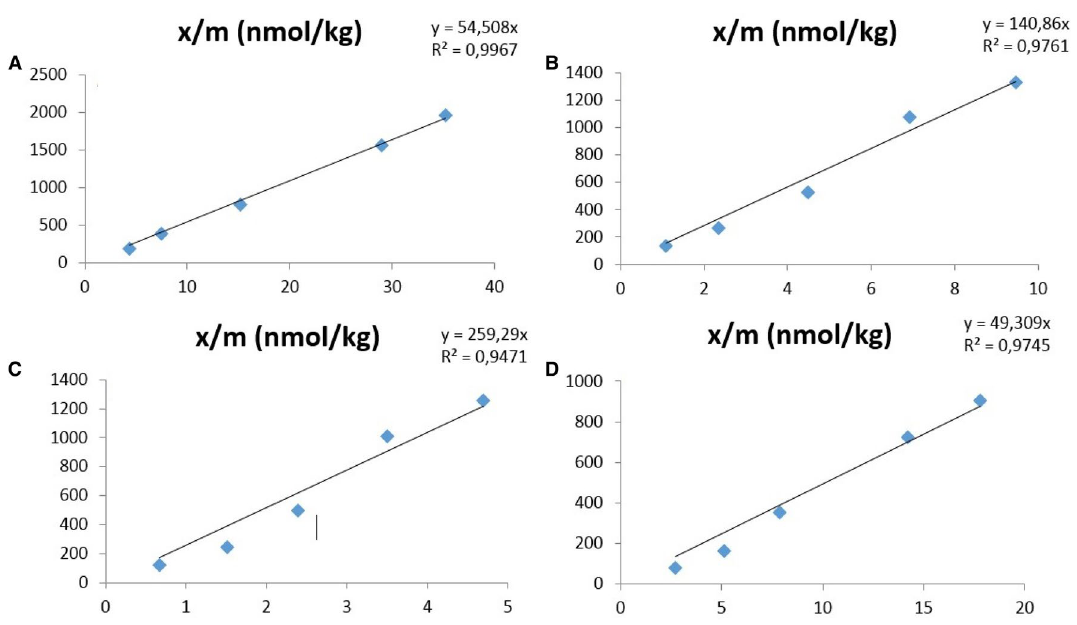
Fig. 2 Adsorption isotherms for atrazine ( a ), chlorpyrifos ( b ), fluazifop ( c ), and lactofen ( d ) riparian area of soil composed of trees containing high concentrations of organic